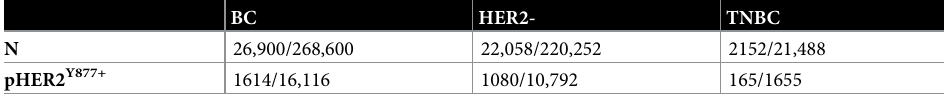
Table 2. pHER2 Y877 distribution according to estimation from Public Health Agency of Canada (PHAC) and U.S Breast Cancer Statistics